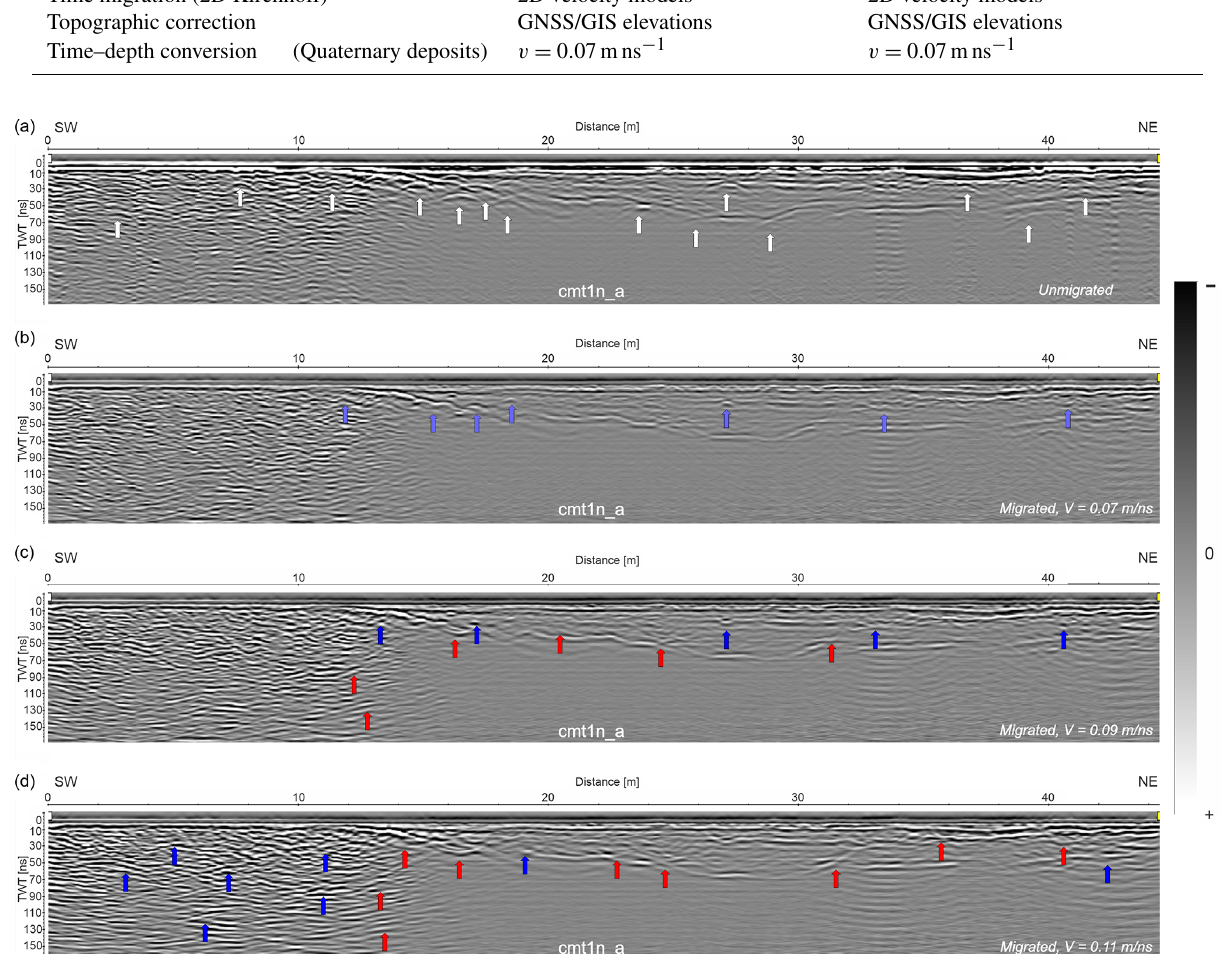
Figure 4. Migration tests performed during the GPR data processing: (a) unmigrated 2D GPR profile, 300MHz antennae, displaying hyper- bolic diffractions (white arrows); (b) migrated profile using a constant velocity v = 0 . 07mns − 1 , light-blue arrows indicate good diffractions collapse; (c) migration output obtained with a constant velocity v = 0 . 09mns − 1 , with dark-blue arrows suggesting good migration results (migration artifacts are shown by red arrows); (d) migration results using a constant velocity v = 0 . 11mns − 1 , with dark-blue arrows high- lighting good hyperbolas collapse, particularly within the high reflective unit; red arrows highlight clear migration